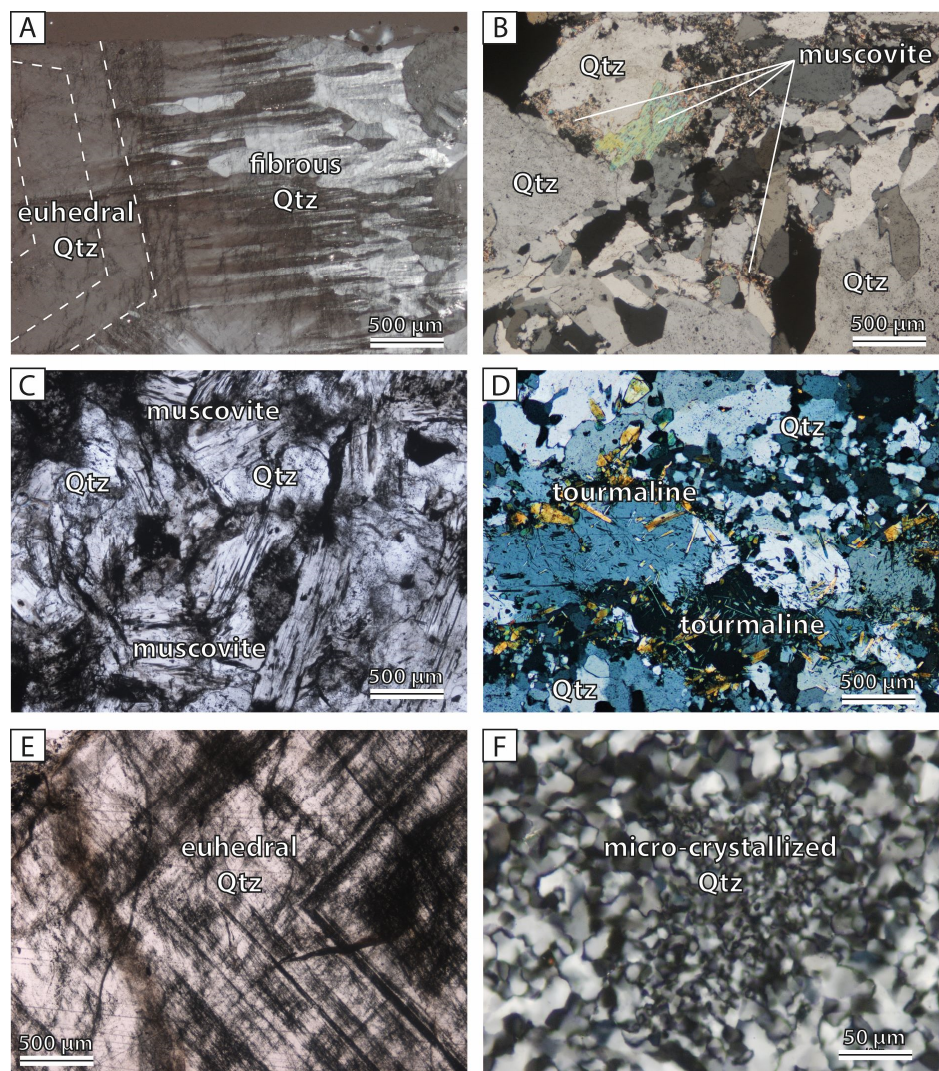
Figure 9. Photomicrographs illustrating quartz textures in the proximal Suchot vein ( A to B ) and its host rock ( C and D ), and in the proximal Mazet veins ( E and F ). ( A ): At Suchot, quartz commonly displays a euhedral core with fibrous overgrowth (XPL). ( B ): A layer in the vein showing well-crystallized muscovite and sericite (XPL). ( C ): In the selvage of the quartz vein, muscovite and quartz have entirely replaced the metamorphic minerals (PPL). ( D ): Detail of a quartz-tourmaline vein that is crosscut by the Suchot vein. Quartz in this vein is recrystallized by GBM (XPL). ( E ), ( F ): First-generation cm-sized euhedral quartz ( E ) and poorly-crystallized second-generation quartz at Mazet ( F )